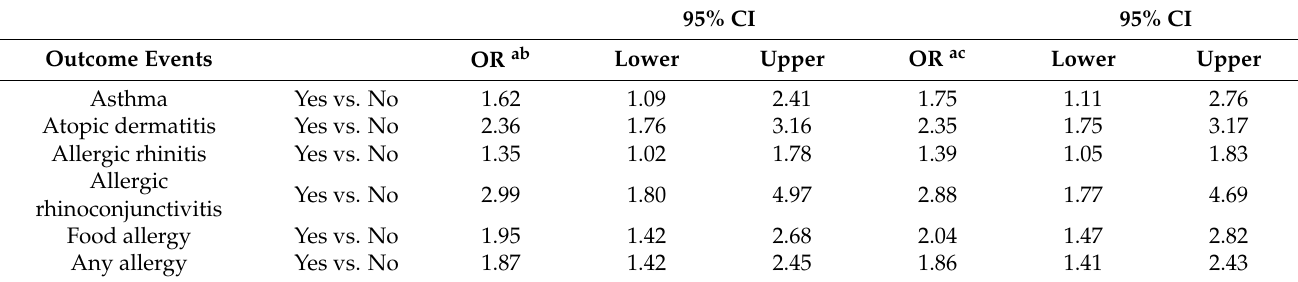
Table 2. Association between atopic diseases at 2 years of age and anemia at 3 years of age in Japanese children assessed using PS analysis. 95% CI 95%